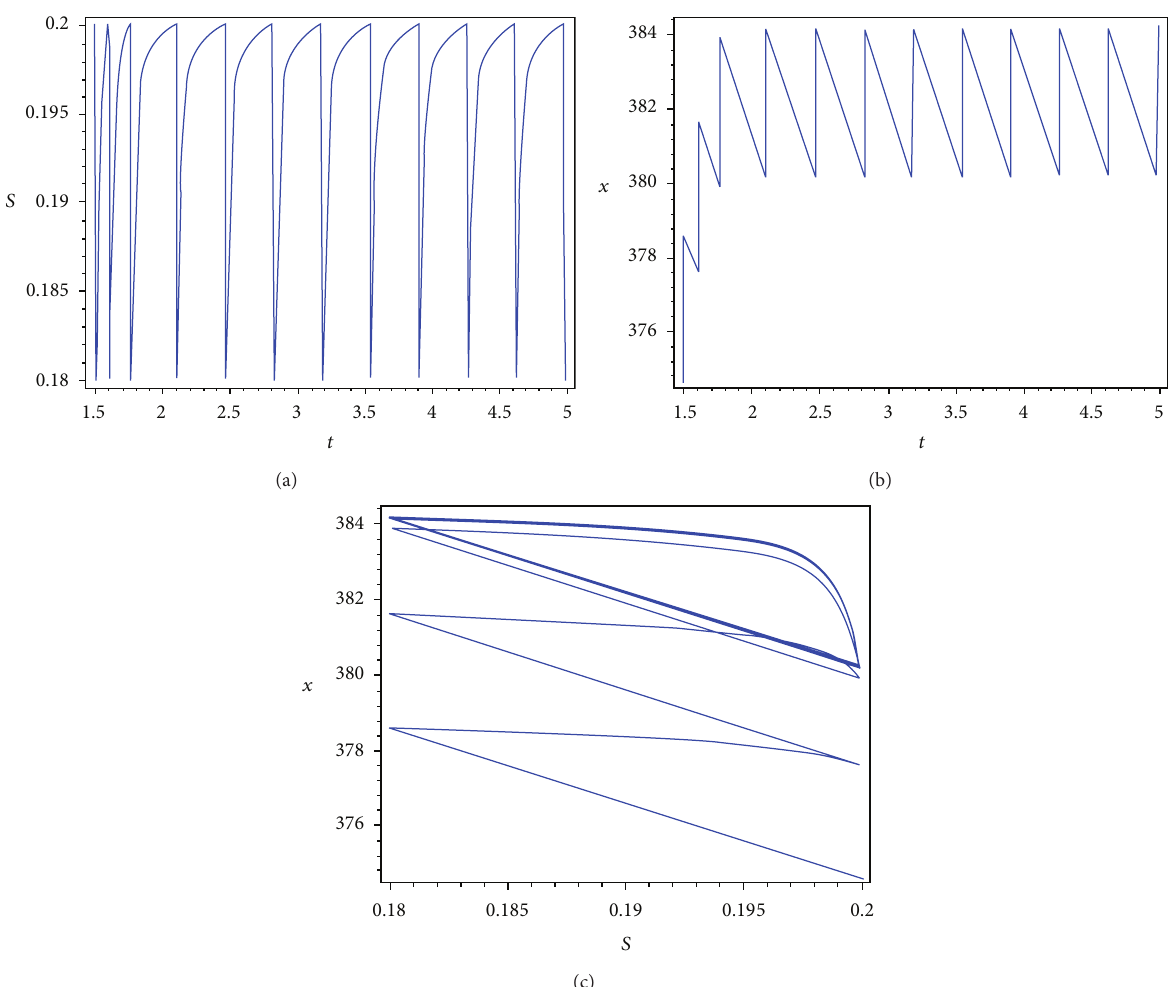
Figure 2: For ℎ < 𝑘𝐷/(𝜇 − 𝐷) , the existence of order-1 periodic solution with the parameters 𝜇 = 0.4 , 𝑄 = 6 , 𝑘 = 4 , 𝑟 = 0.01 , 𝐷 = 0.03 , 𝐸 = 0.1 , 𝜏 = 4 , ℎ = 0.2 , 𝛼 = 0.2 , and 𝛿 = 0.01